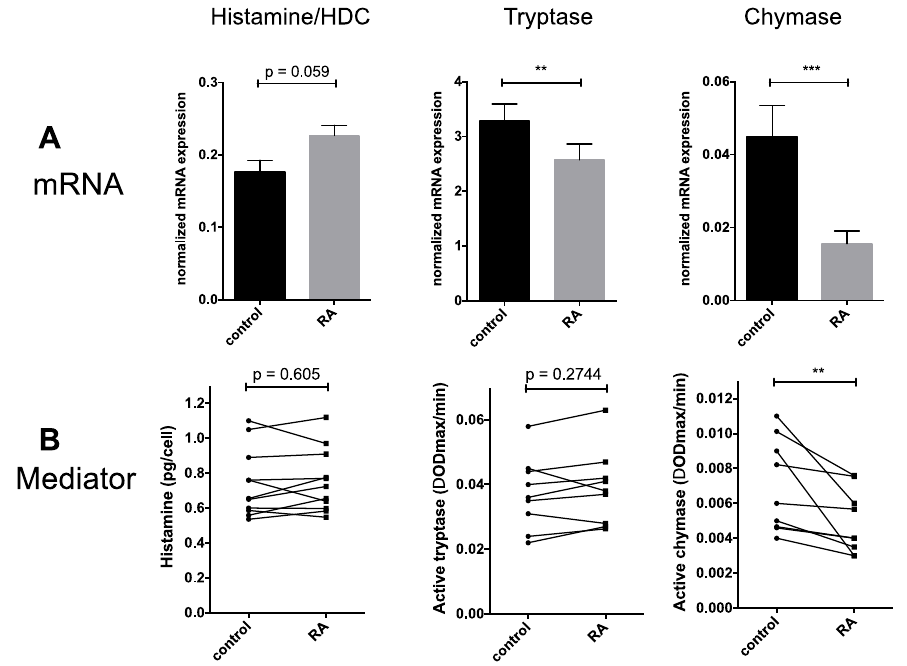
Figure 2. Granule-associated mediators: RA dampens chymase mRNA and chymase activity. ( A ) Relative mRNA expression of histidine decarboxylase (HDC, involved in histamine generation), tryptase and chymase normalized to β actin, respectively, in RA treated and control cells (mean ± SEM, n = 9); ( B ) Mediator contents. Histamine was quantified by an auto-analyzer based method, while tryptase and chymase activity were measured by cleavage of specific substrates in RA pretreated and control cells, as described in the Experimental section. Each dot corresponds to one MC preparation and dots representing the same donor are connected. n = 11 (histamine) or 9 (tryptase, chymase). ** p < 0.01, *** p < 0.001 versus control (by paired t -test).